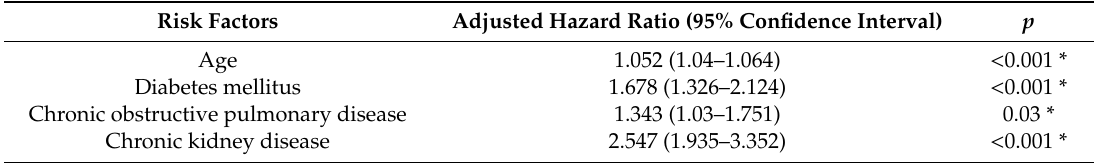
Table 3. Risk factors for one-year mortality after adjusted with other risk factors. Risk